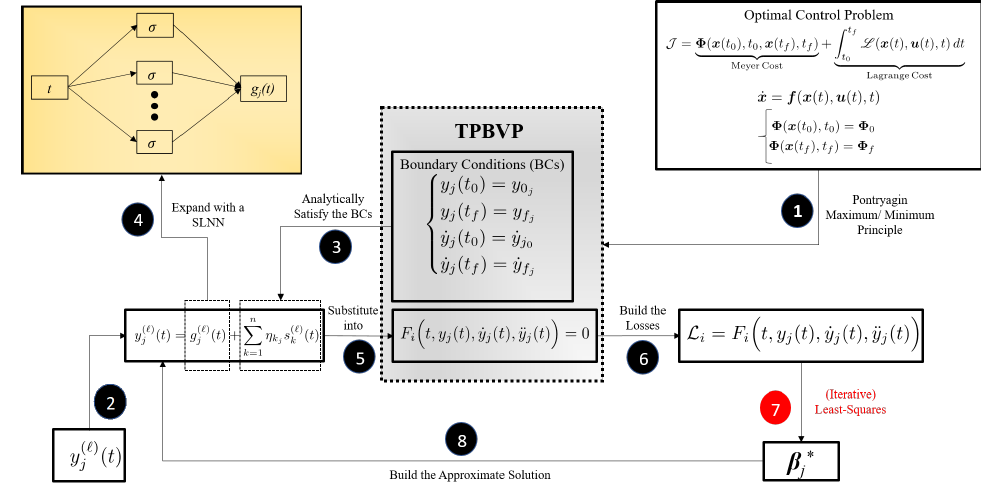
Figure 1. Schematic summarizing how the PoNNs are modeled and trained for learning optimal control actions for a generic unconstrained